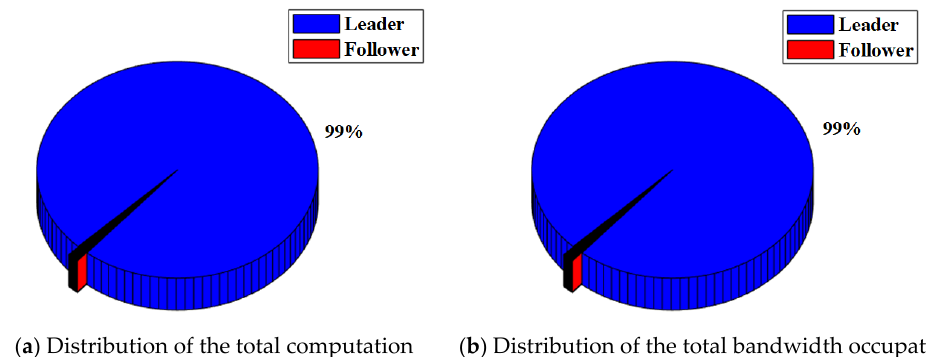
Figure 9. Resource occupation of the RAFT algorithm with malicious nodes.